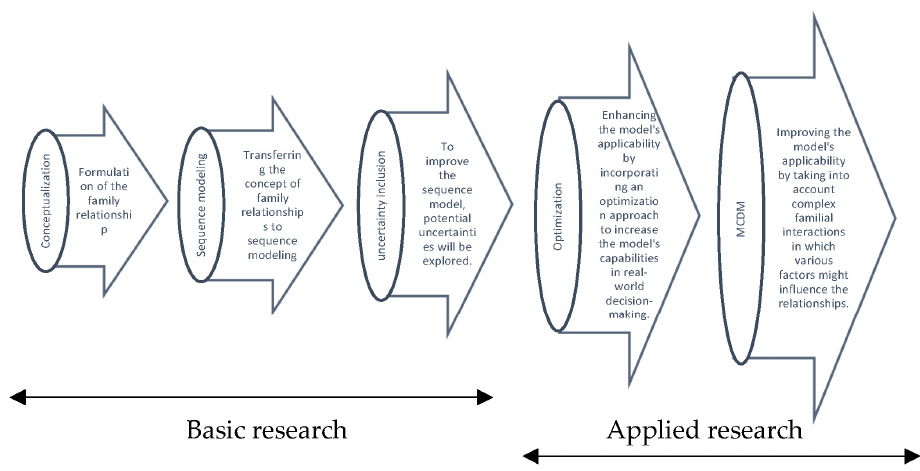
Figure 2. Modeling methodological approach.